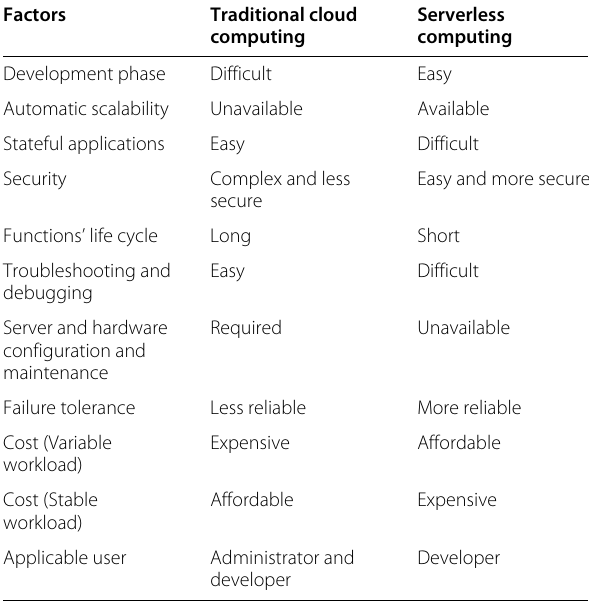
Table 5 Comparison between serverless and traditional